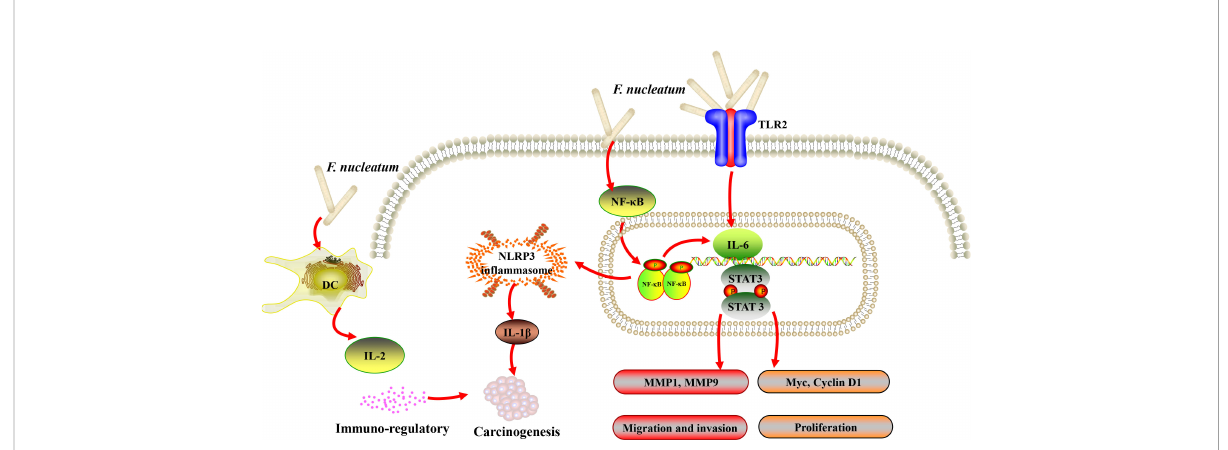
FIGURE 1 A schematic diagram of the proposed in fl ammation and immune response aroused by Fusobacterium nucleatum (F. nucleatum) in oral and head and neck cancer based on the literature review (41, 74, 76, 77, 80).